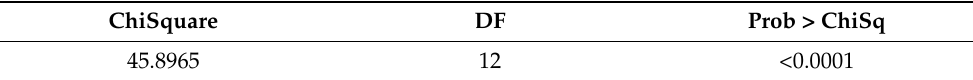
Table 7. Result Kruskal–Wallis tests—analysis of variability PID with the influence of the